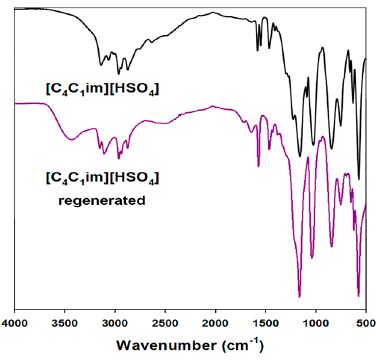
Figure 7. Attenuated total reflection (ATR) spectra of used and regenerated ionic liquids.